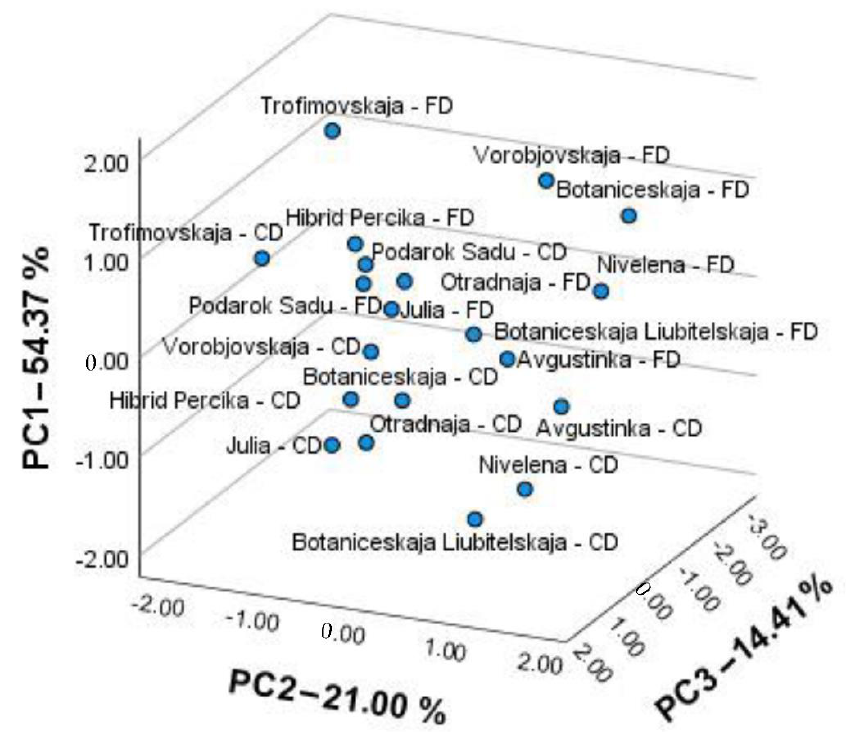
Figure 3. PCA score plots for antioxidant and chromatic characteristics of convection-dried (CD) and freeze-dried (FD) HR cultivars’ leaf powders.